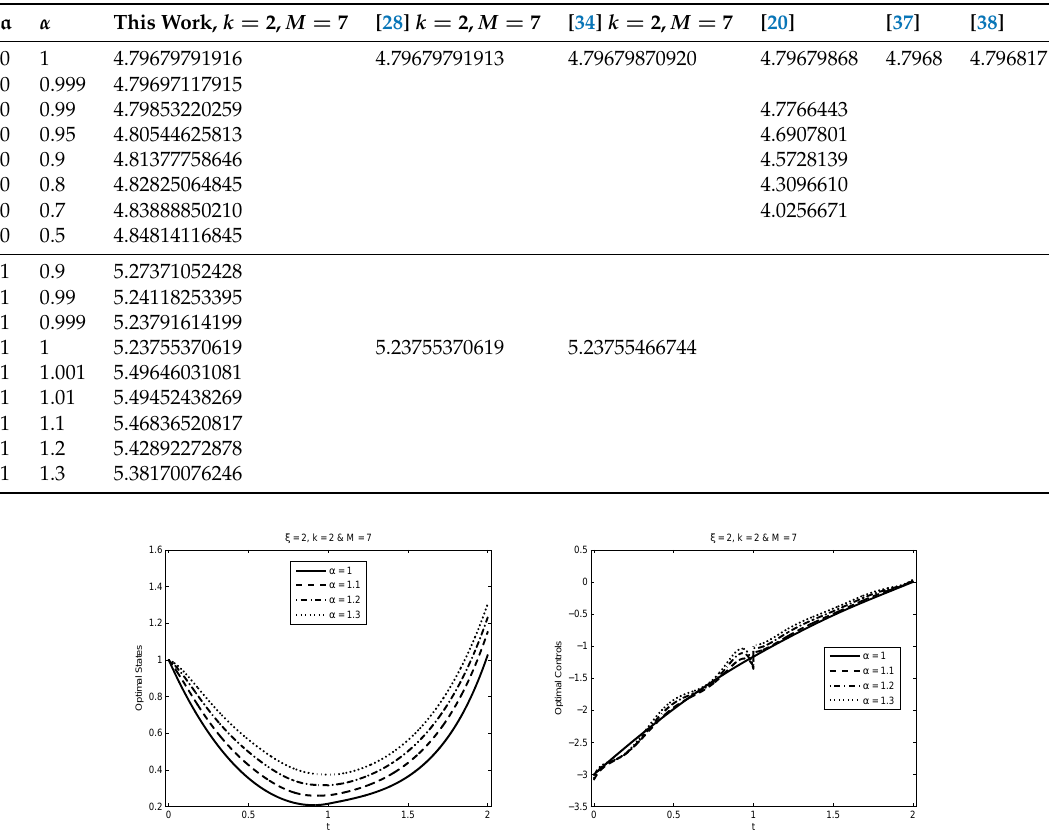
Table 4. Comparison of J ∗ for Example 2.